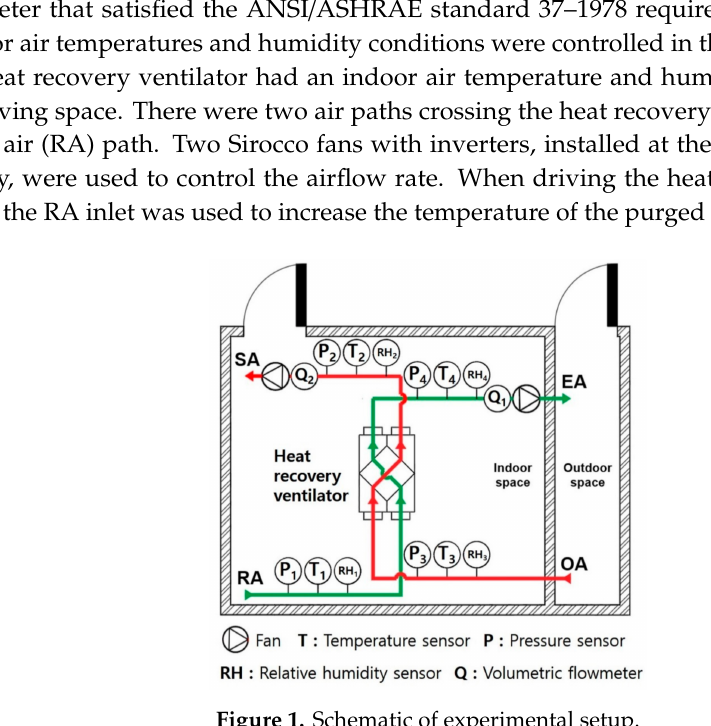
Figure 1. Schematic of experimental